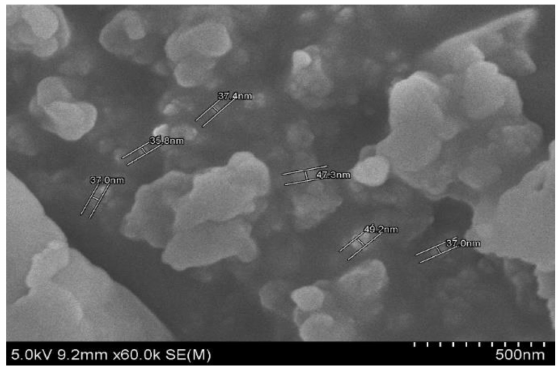
Figure 4. Scanning electron microscopy (SEM) image of the synthesized copper